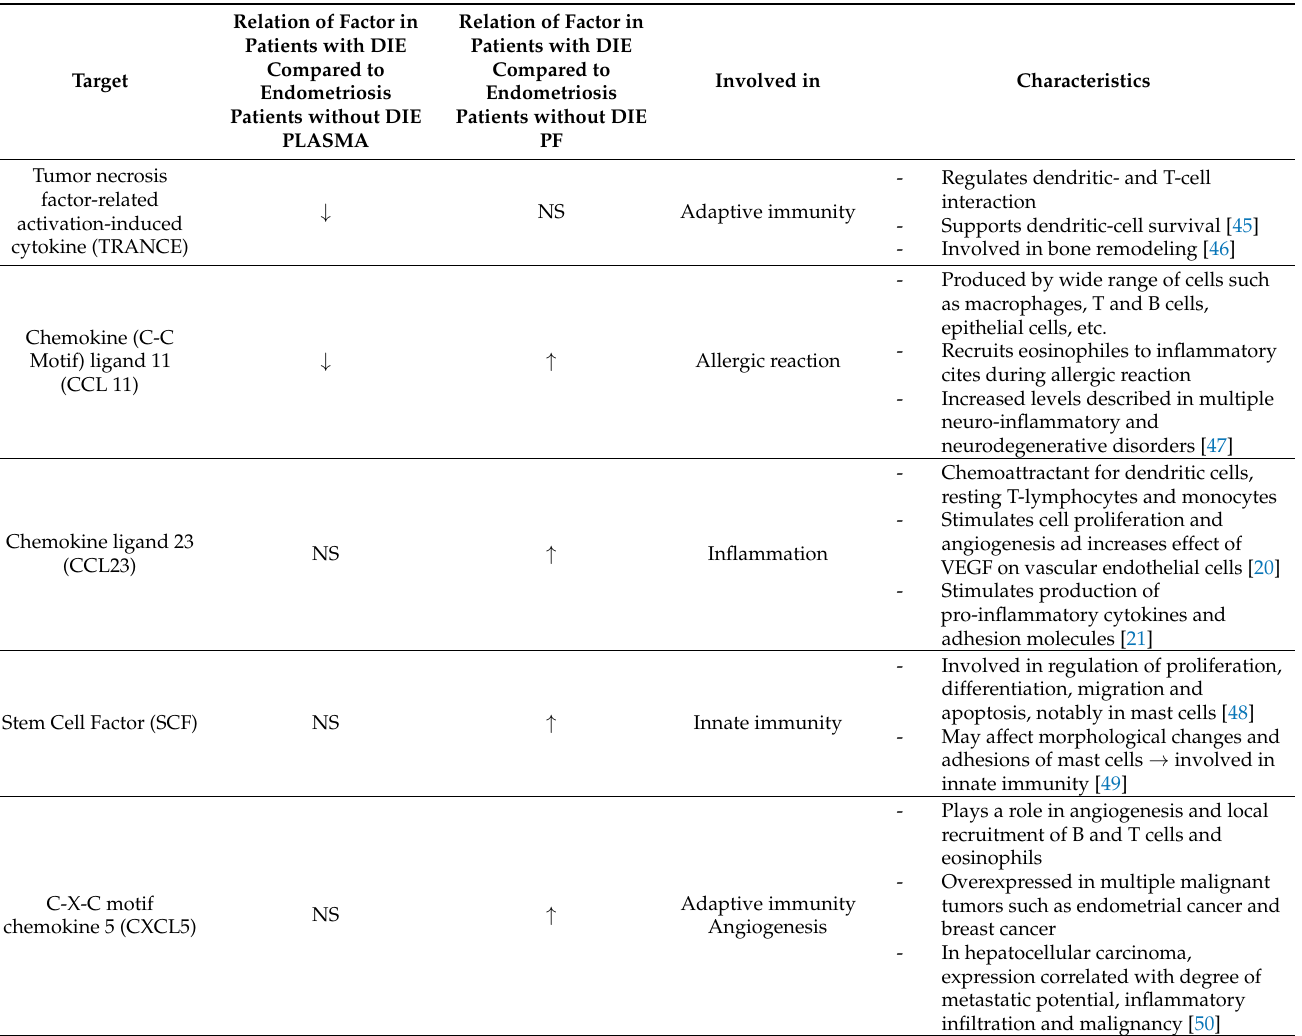
Table legend— ↑ : increased, ↓ : decreased, NS: not significant, PF: peritoneal fluid, VEGF: Vascular Endothelial Growth